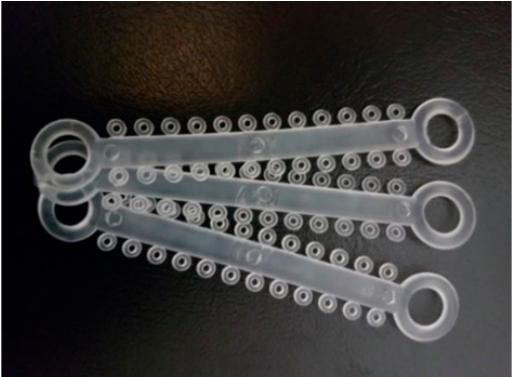
Figure 3. Elastomeric ligatures used in the study (Opal Orthodontics, Ultradent, South Jordan, UT,